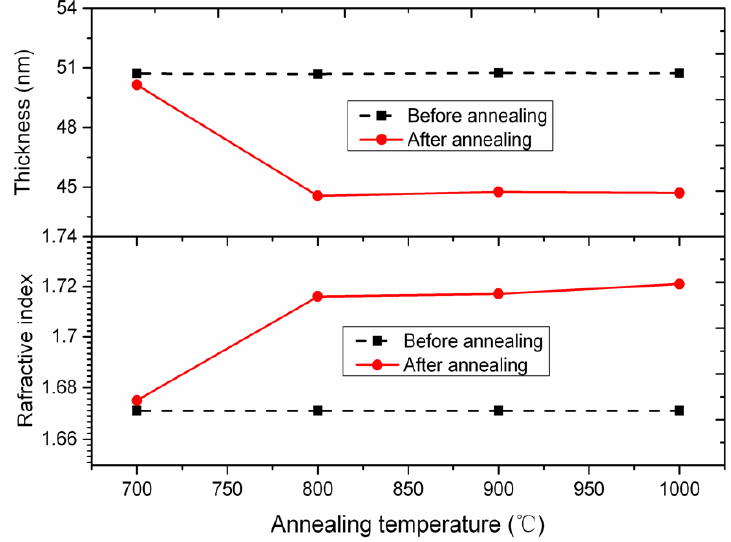
Figure 4. Variation of film thickness and refractive index versus annealingtemperature.